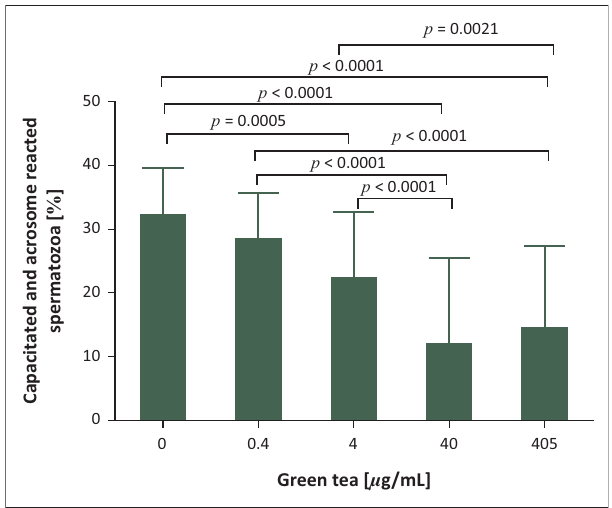
FIGURE 4: Effect of green tea aqueous extract on capacitated and acrosome reacted spermatozoa. Data are represented as mean ± standard deviation from normozoospermic semen samples ( n = 40).